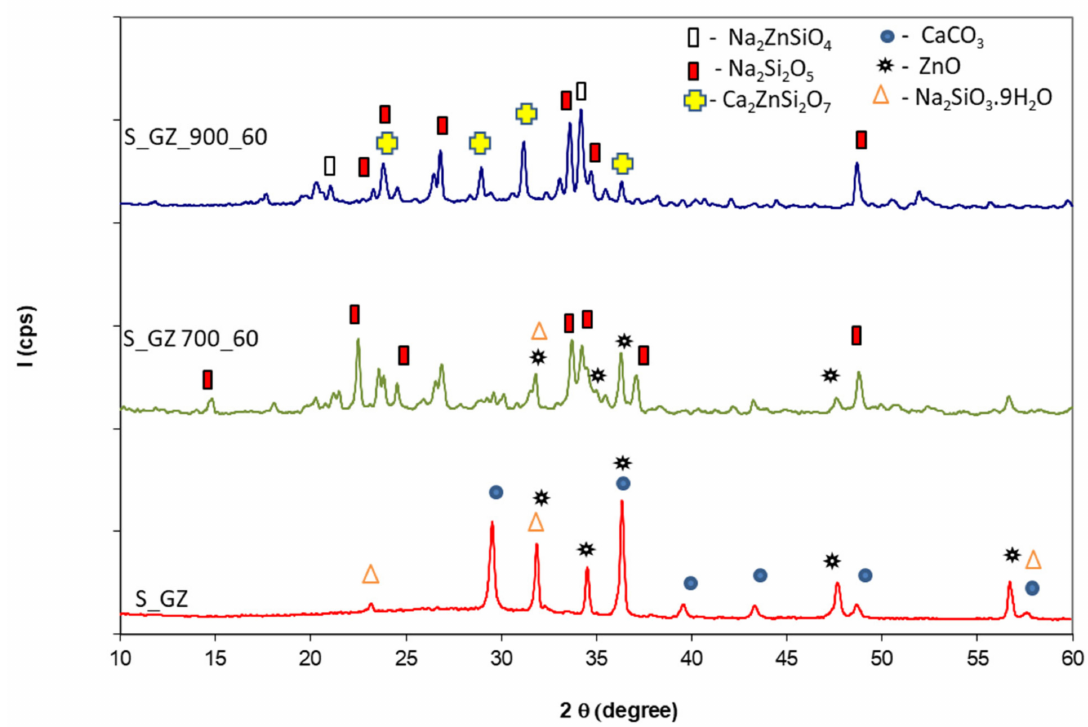
Figure 6. XRD patterns of the coating with GZ addition before and after thermal treatment at 700 ◦ C and 900 ◦ C for 60